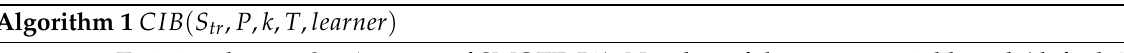
Algorithm 1 CIB ( S tr , P , k , T , learner